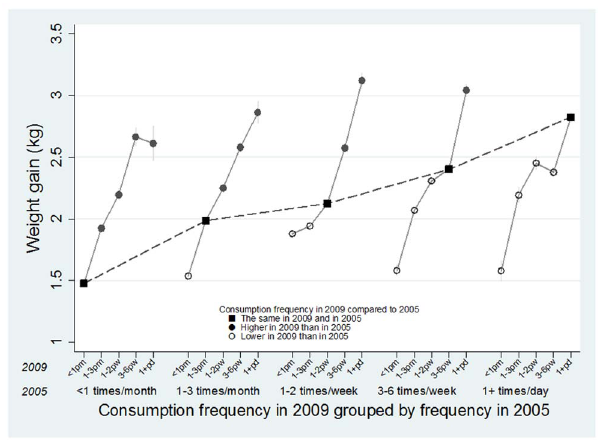
Figure 2. Estimated weight gain by SSB consumption frequen- cy in 2005 and 2009. Estimates were derived from a regression model adjusting for socio-demographic characteristics and lifestyle factors (smoking, drinking, physical activity and energy-dense